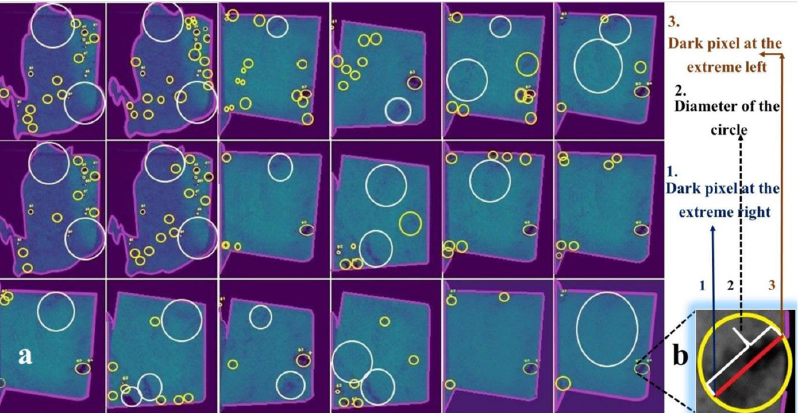
Figure 5. ( a ). Regions encircled in yellow are identified as pores, whereas the regions encircled with white circles are recognized as fractures. ( b ). Enlargement of one pore and its detection policy. These samples have undergone Gaussian smoothing. and hence the difference is to the naked Table 1. Comparing the accuracy of the proposed k -IN with that of the supervised deep-CNN ap- proach. Here, we found the accuracy of the proposed approach outperforms the deep-CNN. Accuracy